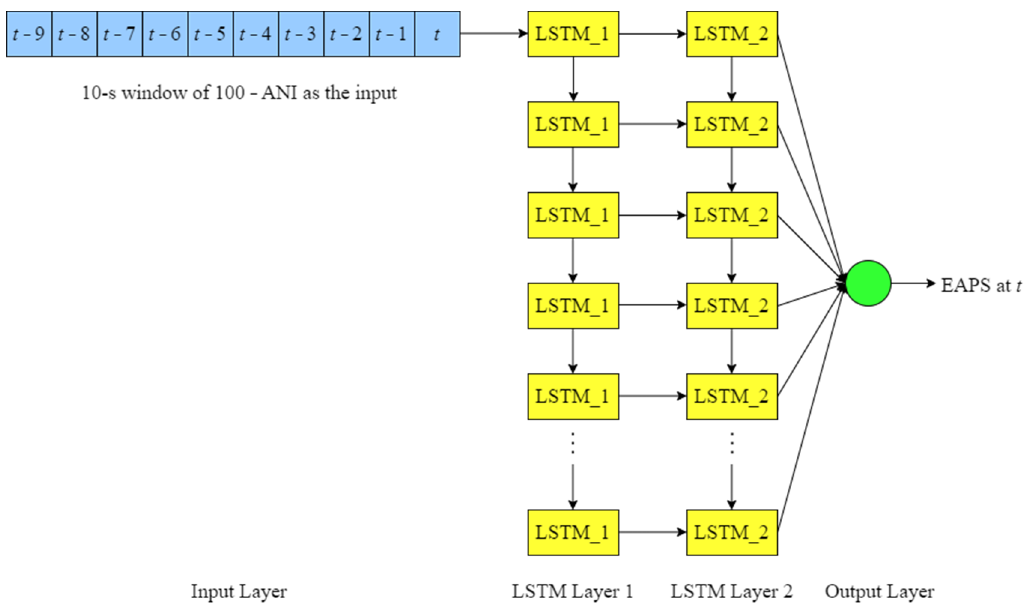
Figure 13. Illustration of the LSTM model architecture.